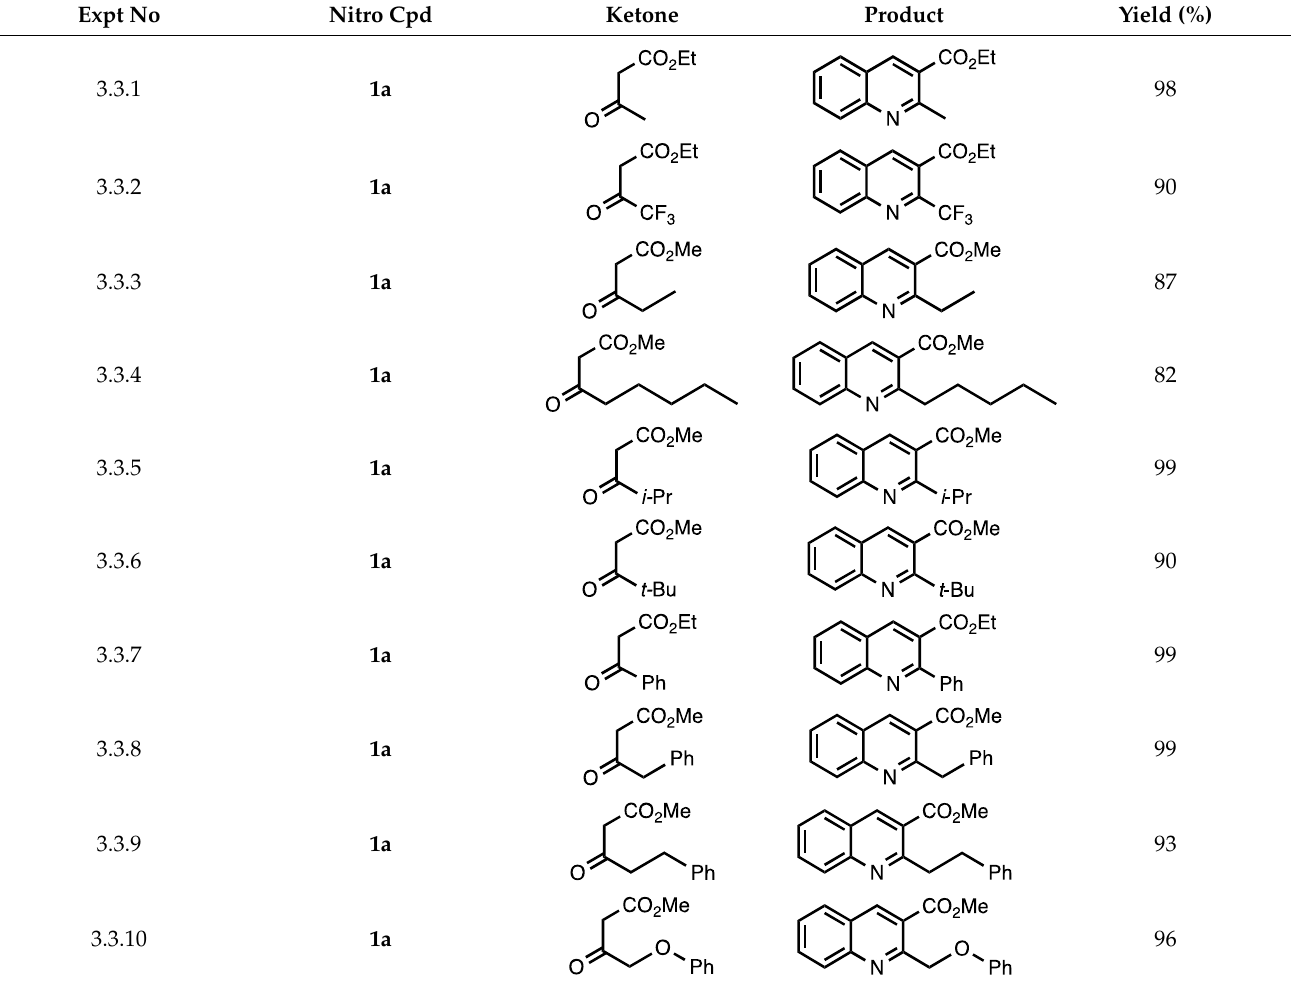
Table 1. Domino nitro reduction-Friedländer reaction using 2-nitrobenzaldehyde ( 1a ).